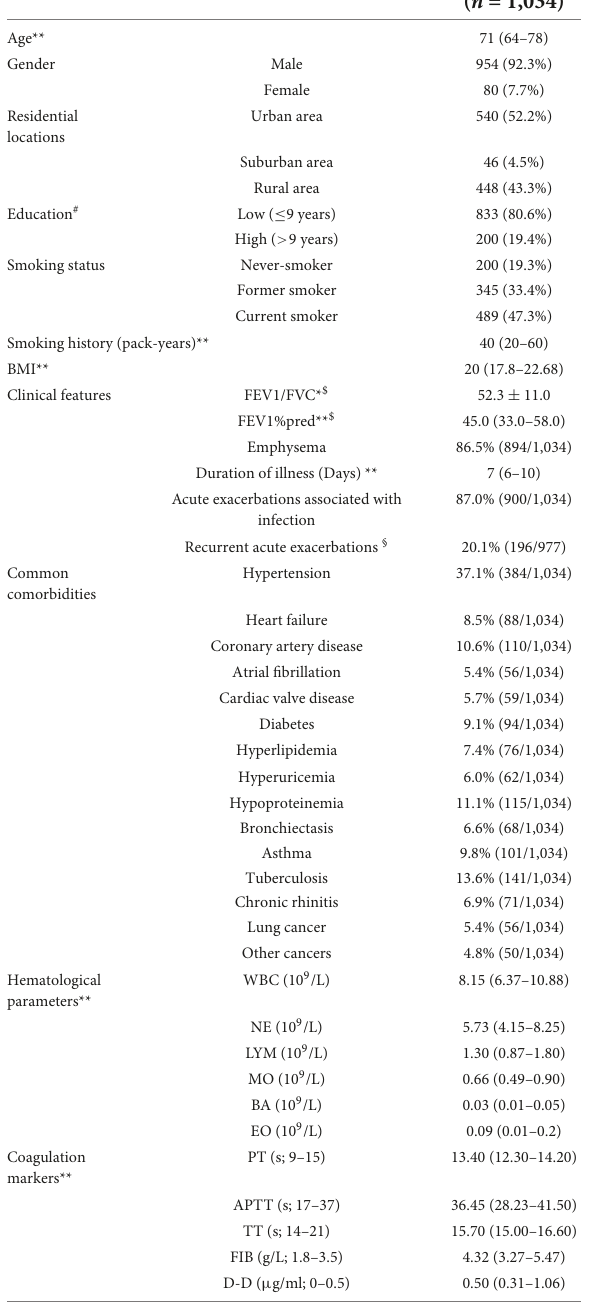
TABLE 1 Demographic, clinical, and laboratory features of patients with acute exacerbations of chronic obstructive pulmonary disease